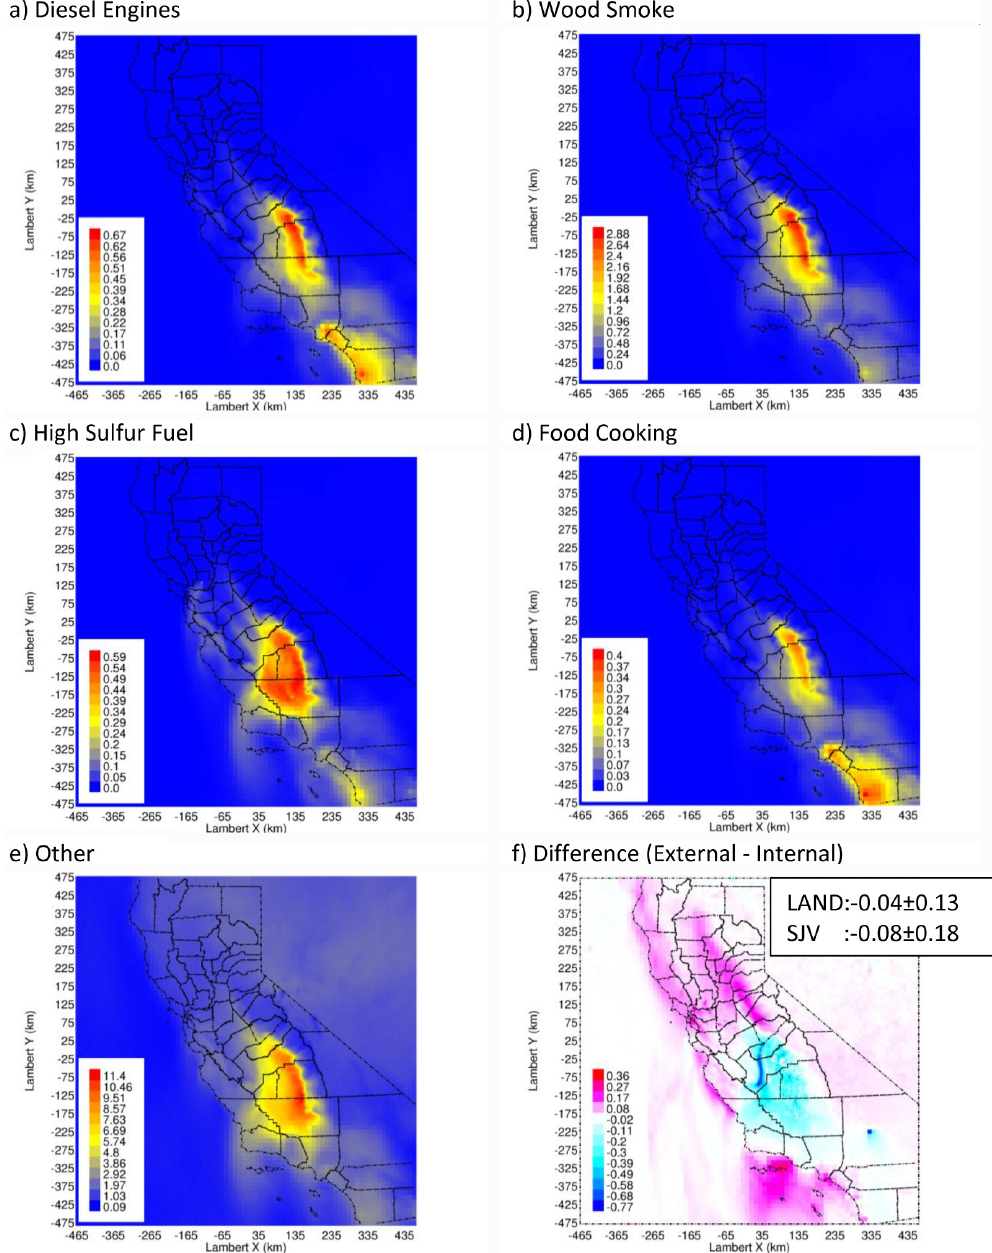
Fig. 9. 24h averaged nitrate concentrations associated with primary particles emitted from different sources predicted by the external case (a–e) on 24 December 2000 and difference between external case and internal case (f) . Units are µgm − 3 . Note that the maximum value for each panel is adjusted to best illustrate the spatial patterns. Averaged differences over land and the SJV covered by the 4km domain are shown in the text